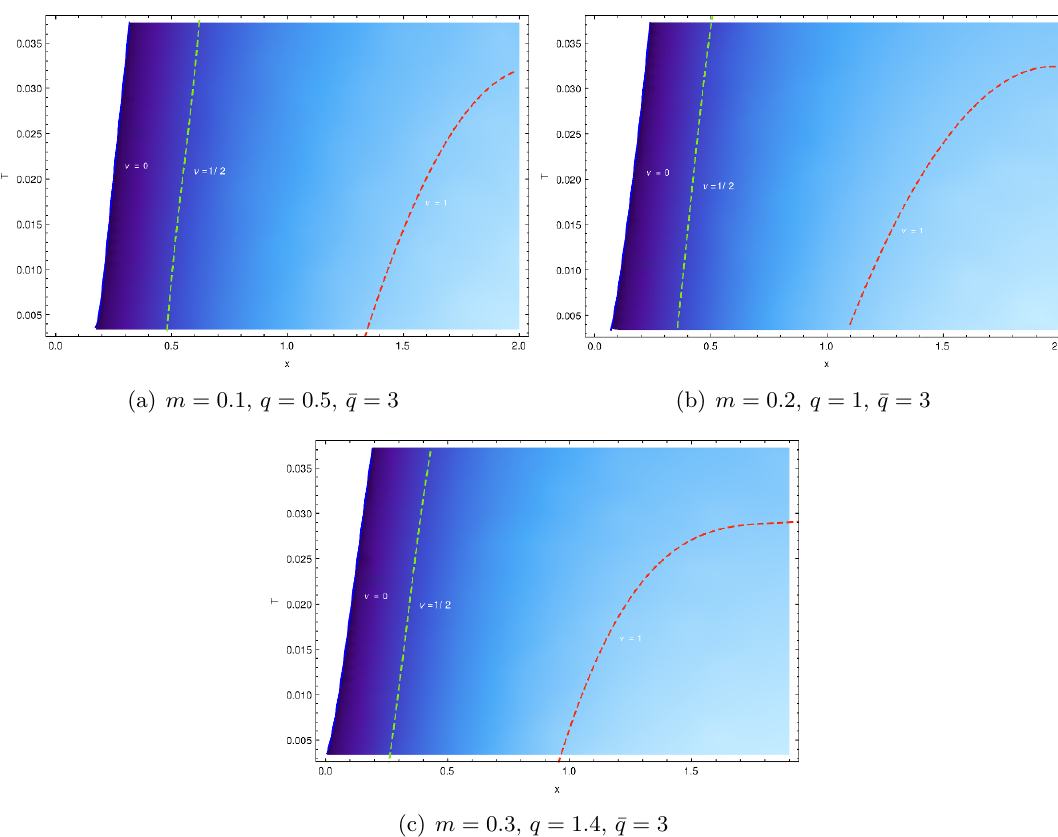
Figure 3 . The T vs. x plane, shaded according to the values of (cid:23) k . Darker regions correspond to F smaller (cid:23) k , while lighter regions correspond to larger values. In the white regions (cid:23) k is complex. F F The dashed green line depict the value (cid:23) k = 1 = 2, at the right of which stable quasiparticles F exist. Notice that the line is tilted to the right, implying that the critical value of x increases with temperature. The dashed red line depict the value (cid:23) k = 1, at which the lifetime of the F quasiparticles scales like that of a Landau Fermi liquid.